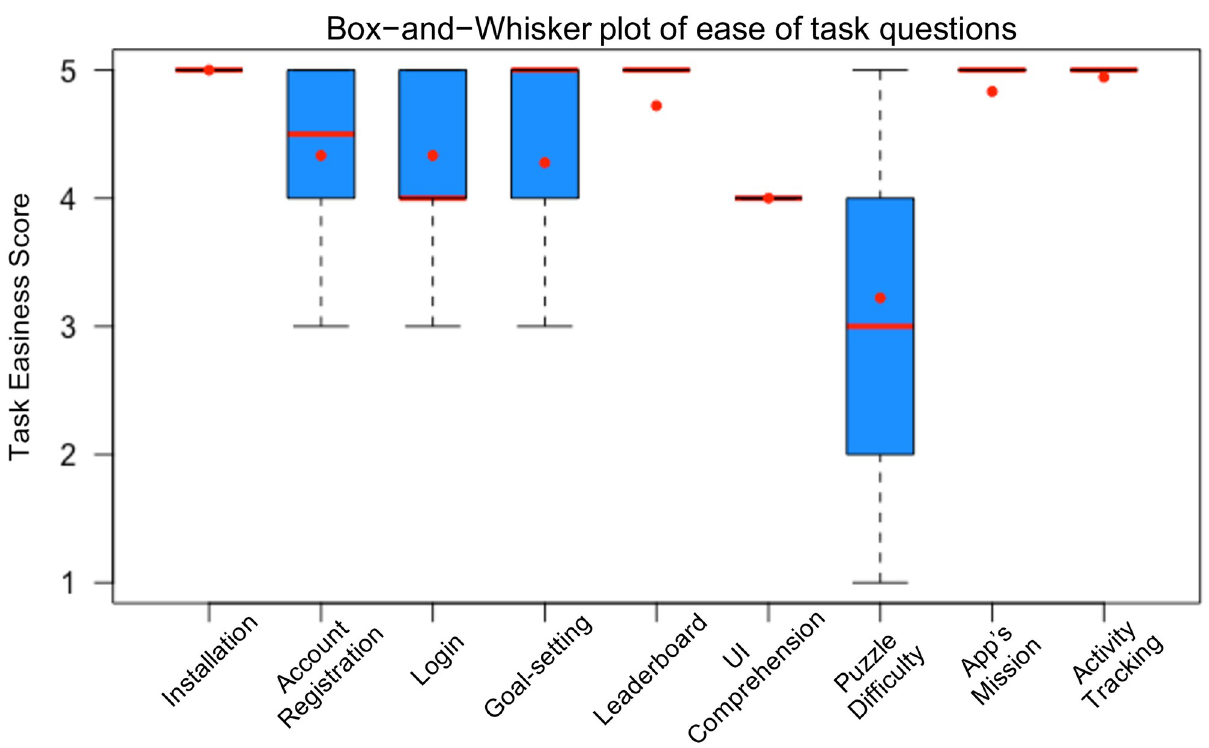
Fig 5. Cognitive walktrough results (1 = “very difficult” to 5 “very easy”; red lines = median and red dots = mean).